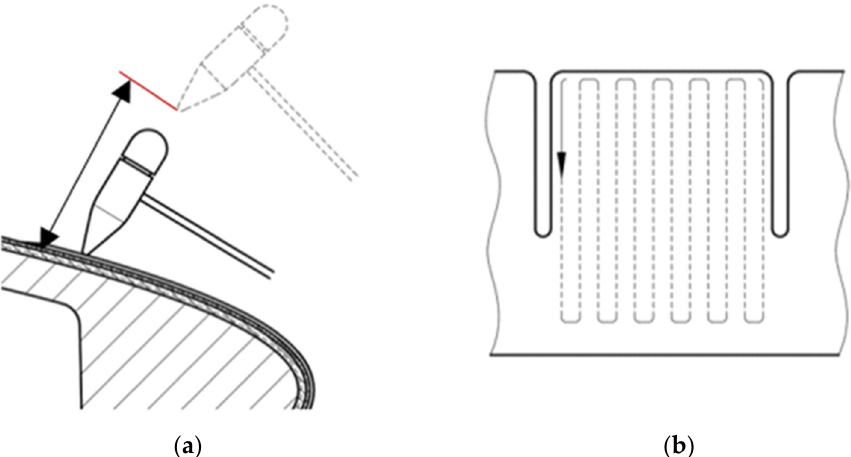
Figure 21. Non-destructive testing: ( a ) Method of tap-test with an inspection hammer; ( b ) Trajectory of the tap-test.